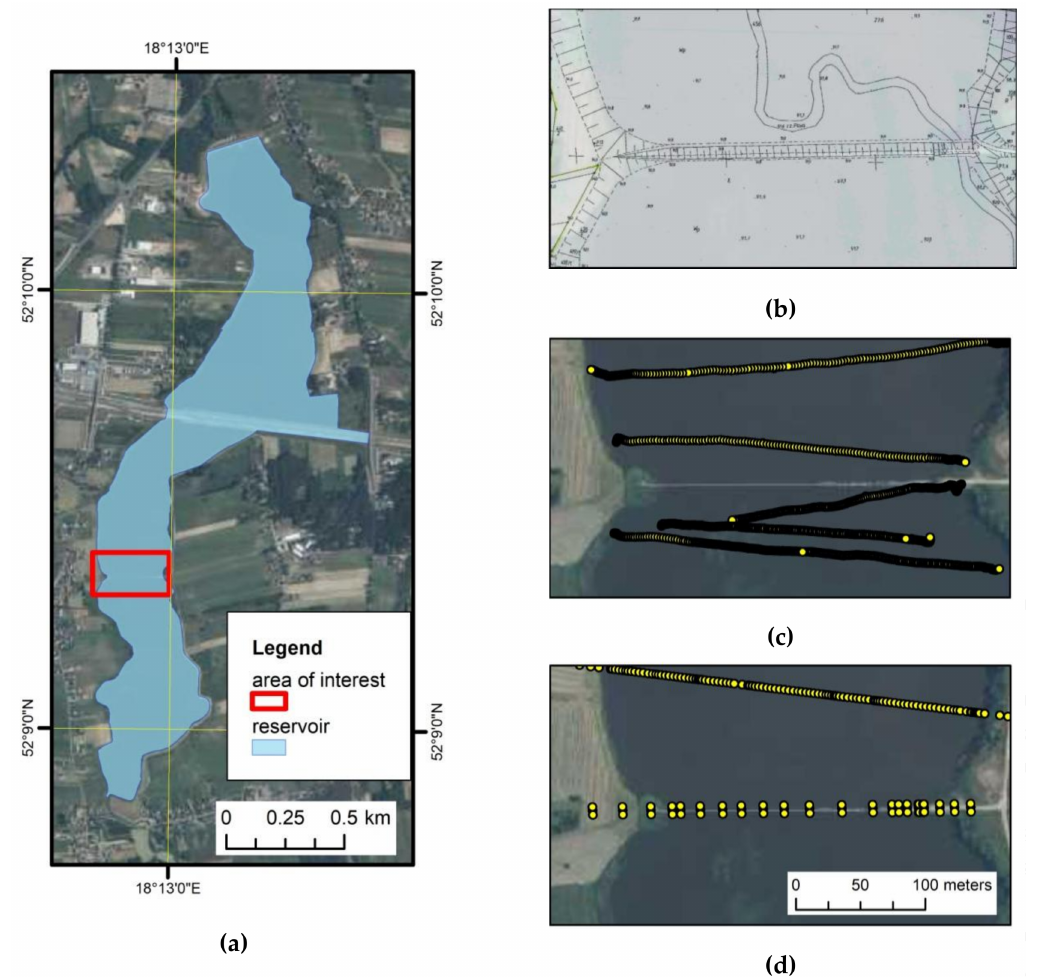
Figure 5. Examples of data used for the reconstruction of the reservoir bathymetries: ( a ) Location of the selected area; ( b ) design map from 2006; ( c ) measurement points from 2013; ( d ) measurement points from